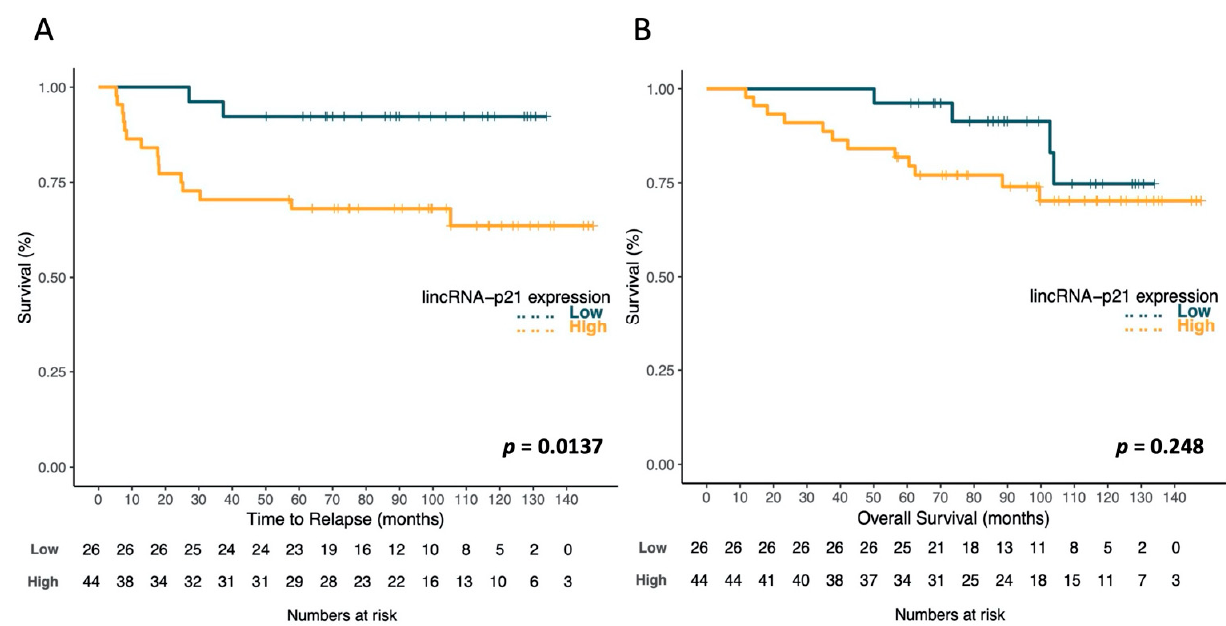
Figure 3. Kaplan–Meier curves for time to relapse (TTR) ( A ) and overall survival (OS) ( B ) according to lincRNA-p21 expression levels in 70 rectal cancer patients. The log-rank test was used to calculate whether significant differences in survival times between high or low lincRNA-p21 levels were achieved.